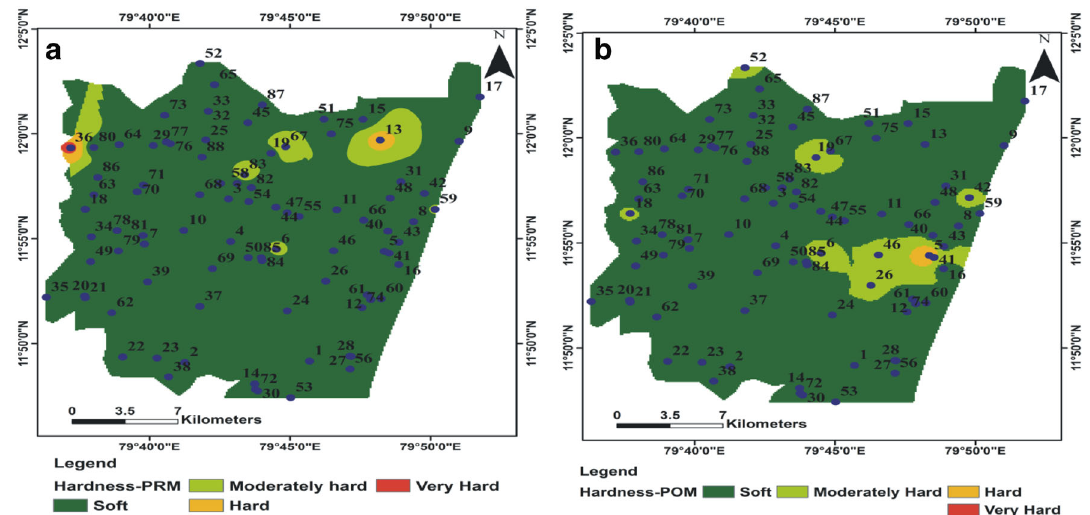
Fig. 13 a , b Spatial distribution map of hardness (pre- and post-monsoon)